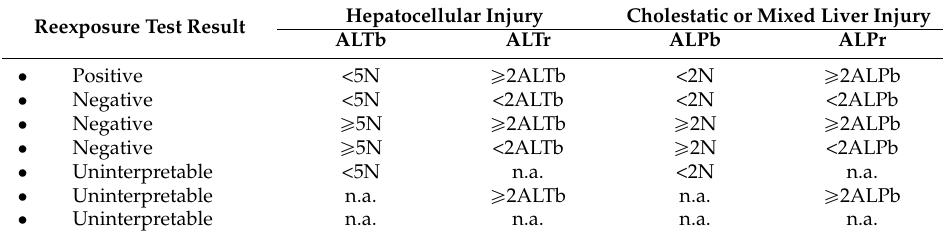
Table 5. Conditions of unintentional reexposure tests in suspected DILI and HILI